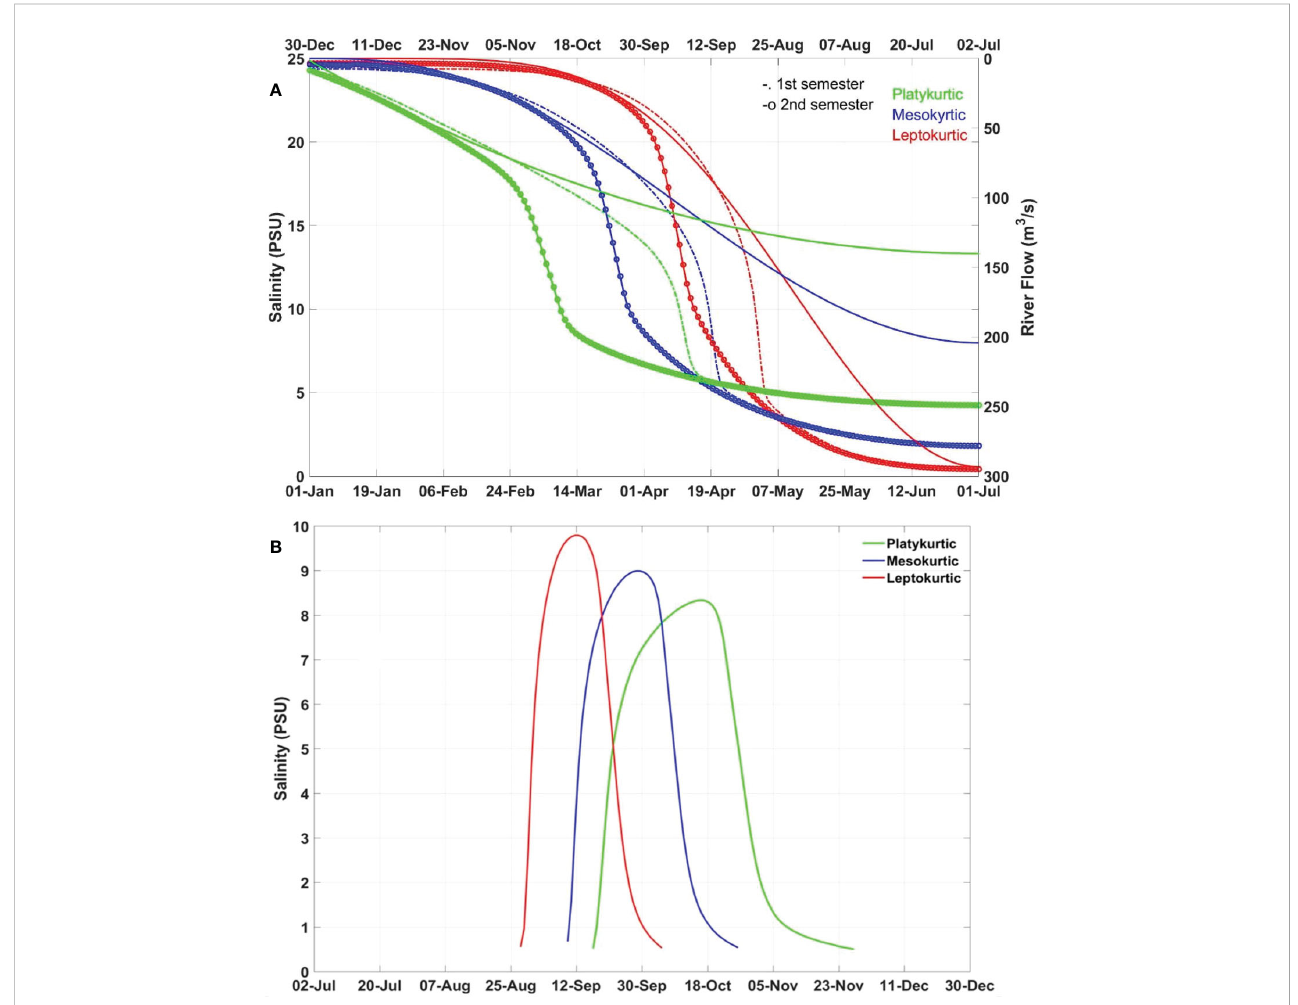
FIGURE 3 (A) A comparison of the mean over depth salinity averaged over a distance of 3 km from the river mouth between the three symmetric distributions. Bottom axis shows the dates of the 1st semester. The dotted lines denote salinity in the 1st semester. Top axis shows the dates of the 2nd semester moving from right to the left. Circled lines denote salinity in the 2nd semester increasing from right to the left. The river discharge of each symmetric distribution is added with continuous lines and with its scale on the right axis. The fl ow increases from 1st of January until 1st of July following the bottom axis and decreases from 2nd of July until 31 of December following the top axis. (B) A timeline of the salinity differences above 0.5 PSU between the 1st and 2nd semester for each symmetric